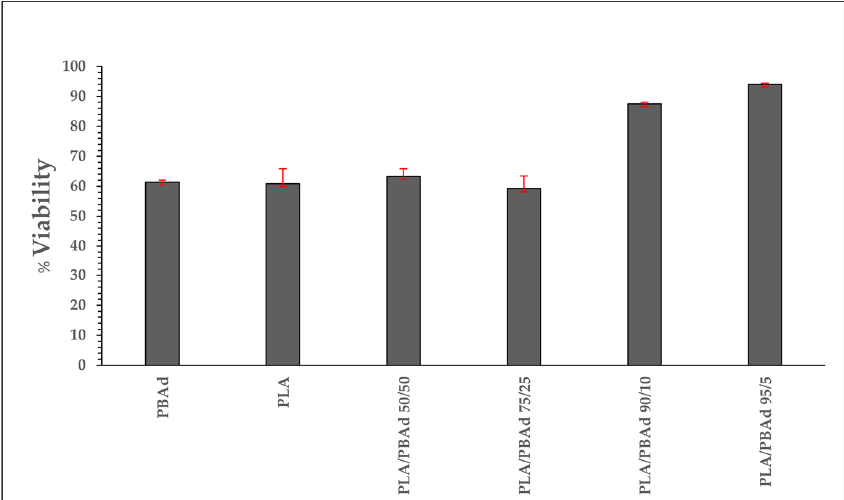
Figure 2. Cytotoxic effect on hAMSCs after incubation with neat PBAd, neat PLA and the newly prepared PLA/PBAd block